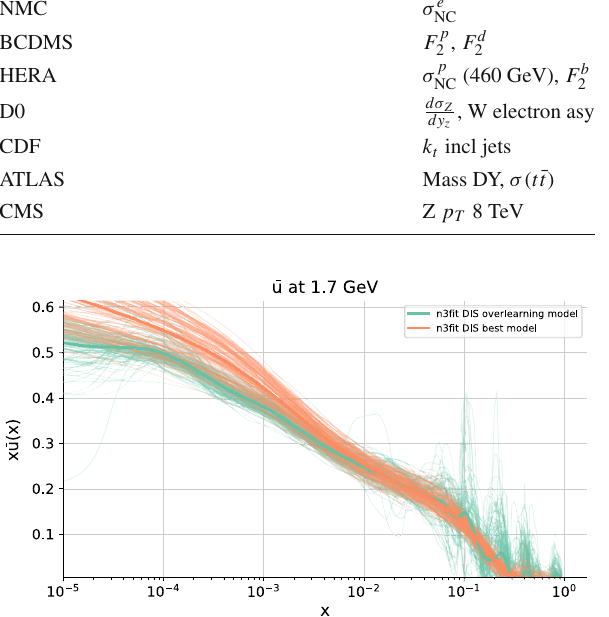
Fig. 4 Comparison between the PDF replicas generated by n3fit for one parton flavour ( ¯ u ). In green we show the results for the best model in the naive hyperoptimization, in orange the best model once we have introduced the test set